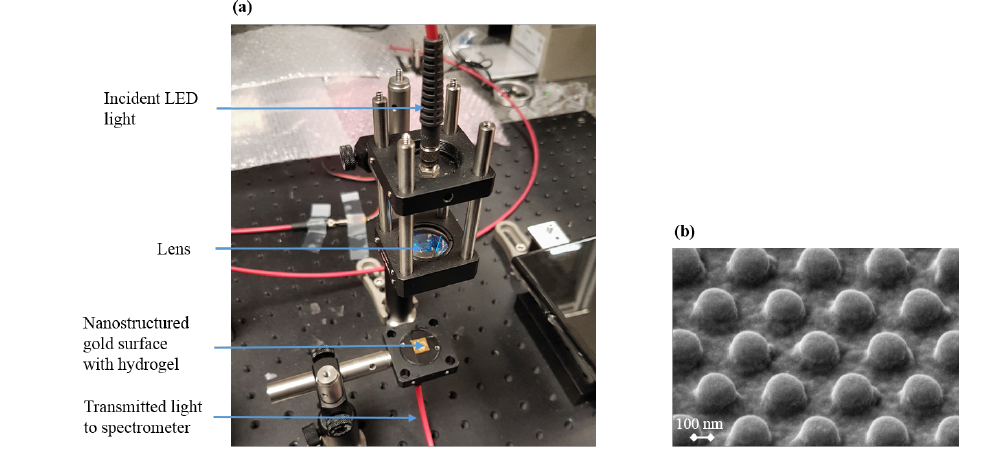
Figure 1. (a) Setup for analyzing the transmittance spectrum of the sensor substrates and (b) REM micrograph of the nanostructured gold